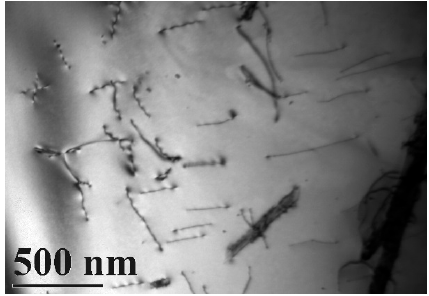
Figure 4. Bright ‐ field TEM image of the as ‐ quenched specimen (Sample B).